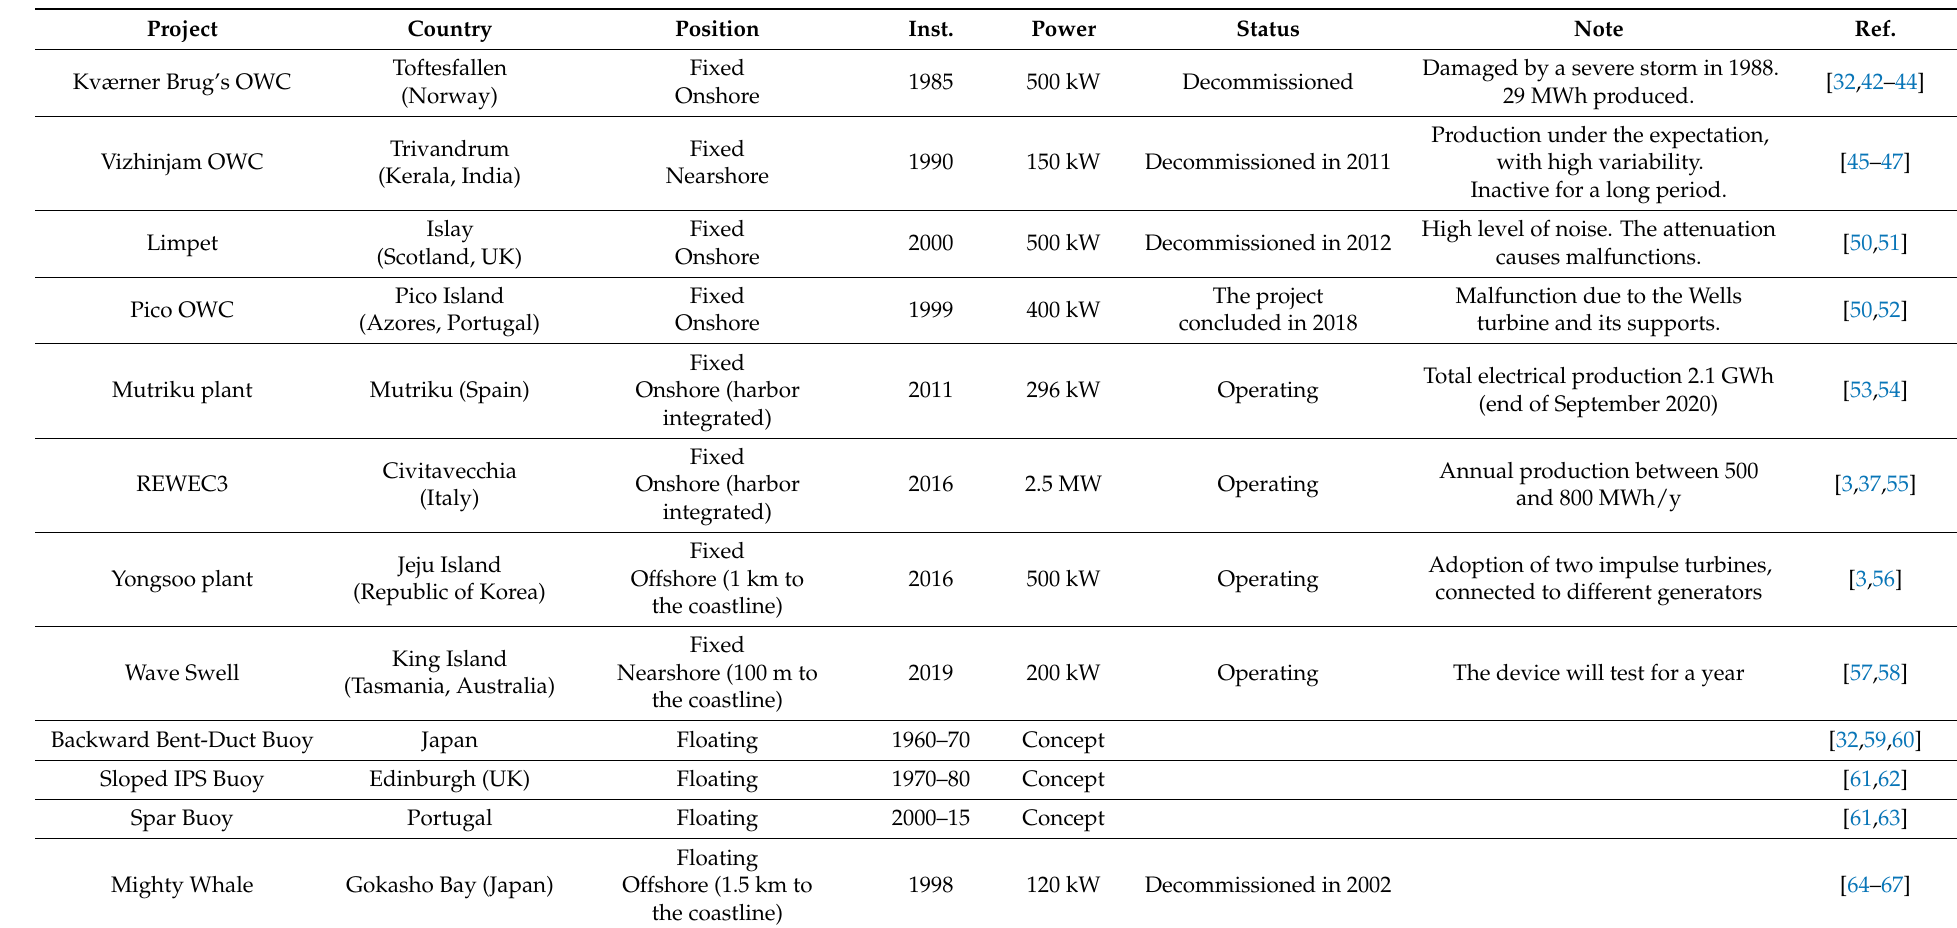
Table 3. Summary of the main OWC